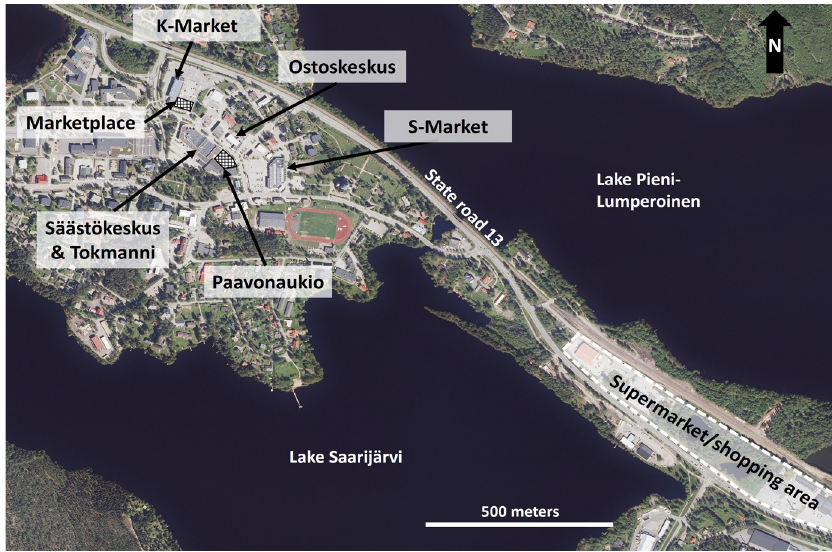
Fig. 6. Downtown Saarijärvi. (Background: Maanmittauslaitos Ortokuva